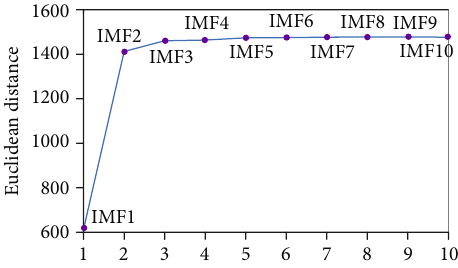
Figure 9: Euclidean distance between each mode and photovoltaic output